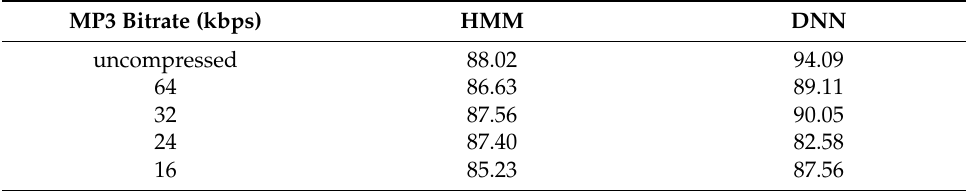
Table 4. HMM and DNN acoustic models bee activity acoustic classification accuracy with MP3 processed